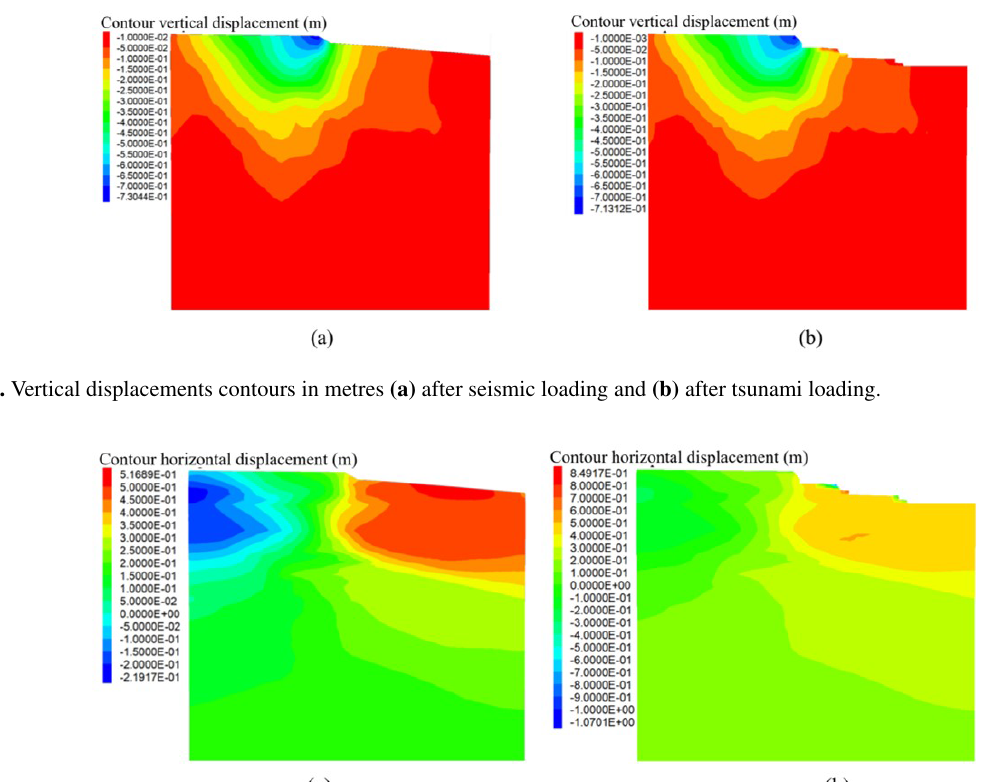
Nat. Hazards Earth Syst. Sci., 22, 2589–2609, 2022